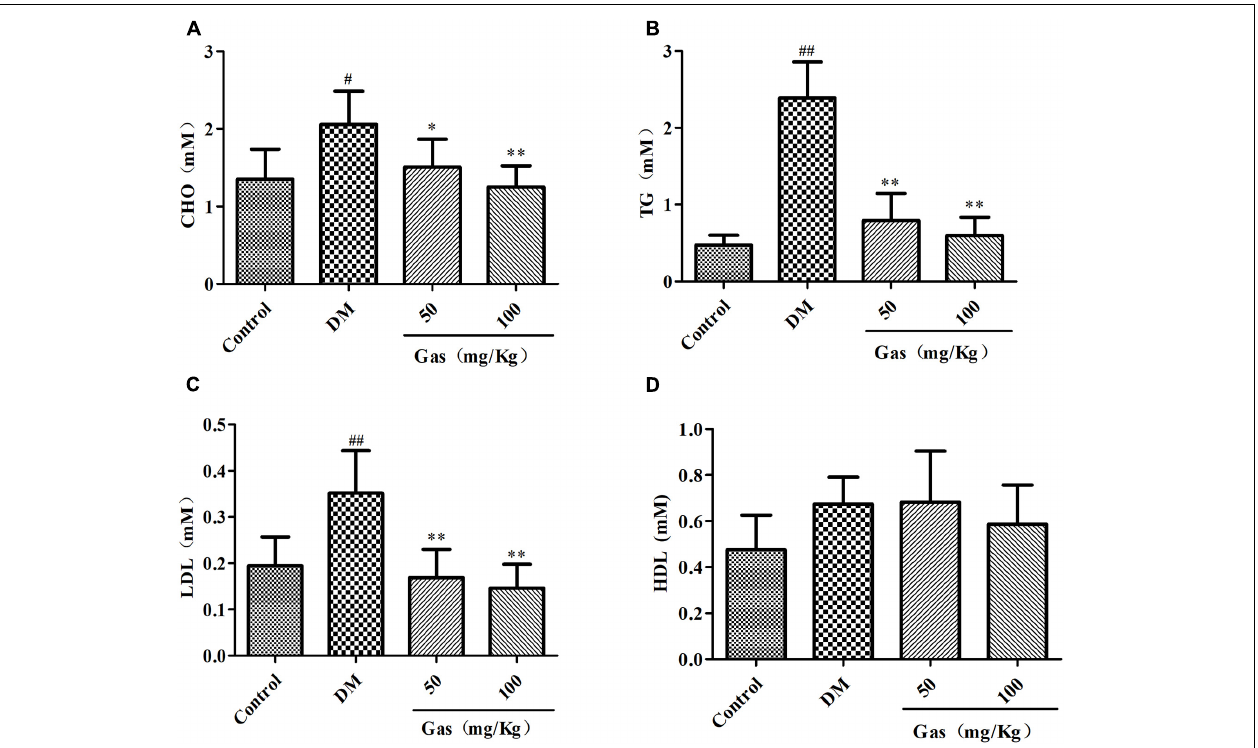
FIGURE 4 | Gas improves dyslipidemia in DM rats. (A) Levels of TC in serum samples of rats after 5 weeks of treatment. (B) Levels of TG in serum samples of rats after 5 weeks of treatment. (C) Levels of LDL-C in serum samples of rats after 5 weeks of treatment. (D) Levels of HDL-C in serum samples of rats after 5 weeks of treatment. Values are represented as means ± SD for 10 rats in each group. # P < 0.05, ## P < 0.01, compared with the control group. ∗ P < 0.05, ∗∗ P < 0.01, compared with the DM group.